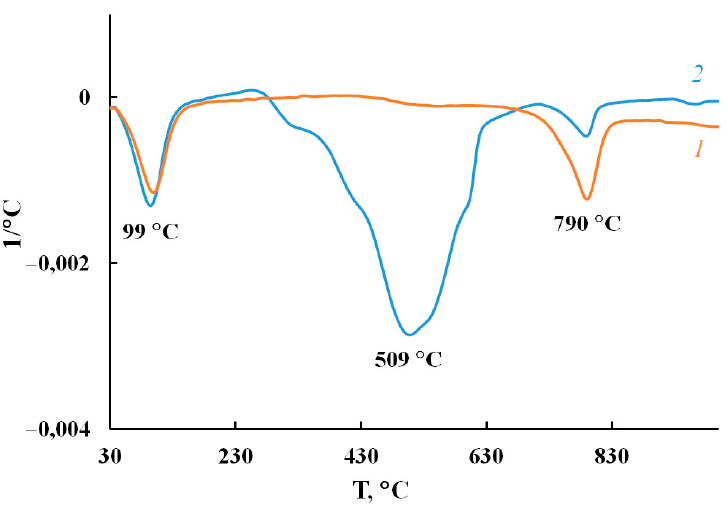
Figure 17. DTG curves of MNP/P ‐ N ‐ PAA, obtained at [Co] = 5 wt%, in the argon flow ( 1 ) and in air ( 2 ).